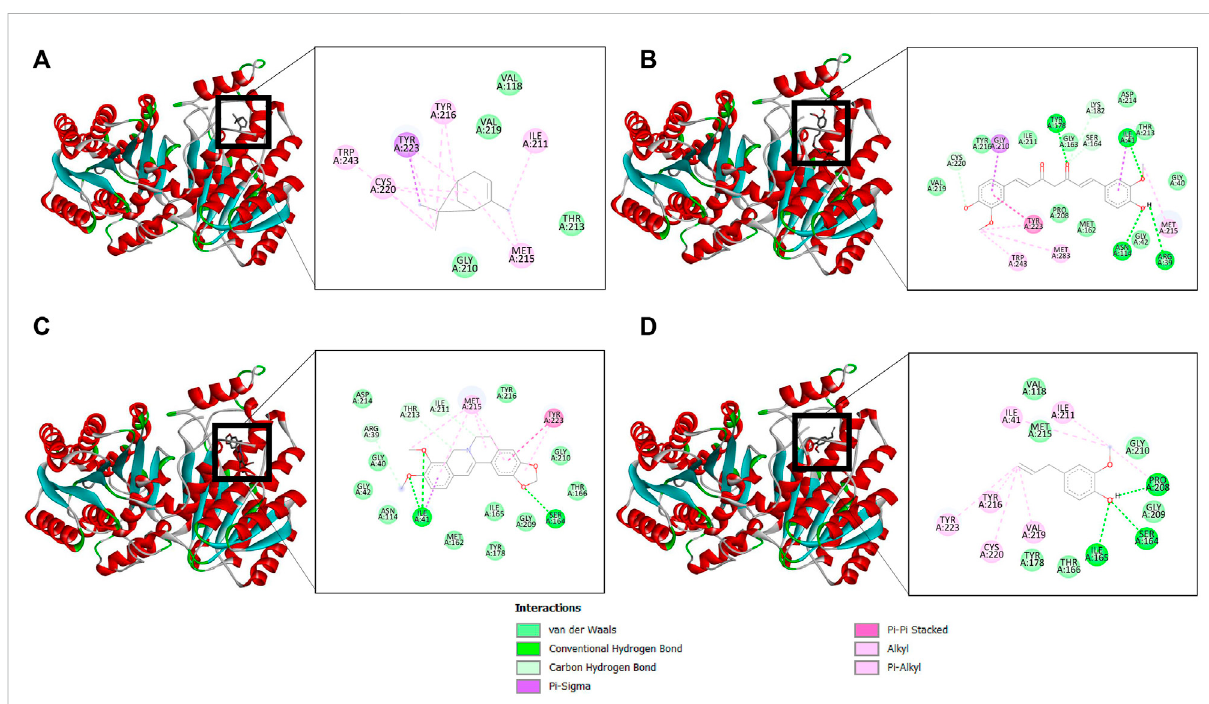
FIGURE 7 Binding of (A) α -pinene, (B) curcumin, (C) berberine, and (D) eugenol with THR. Ribbon and 2D representation of THR protein showing various interactions and docking fi t of